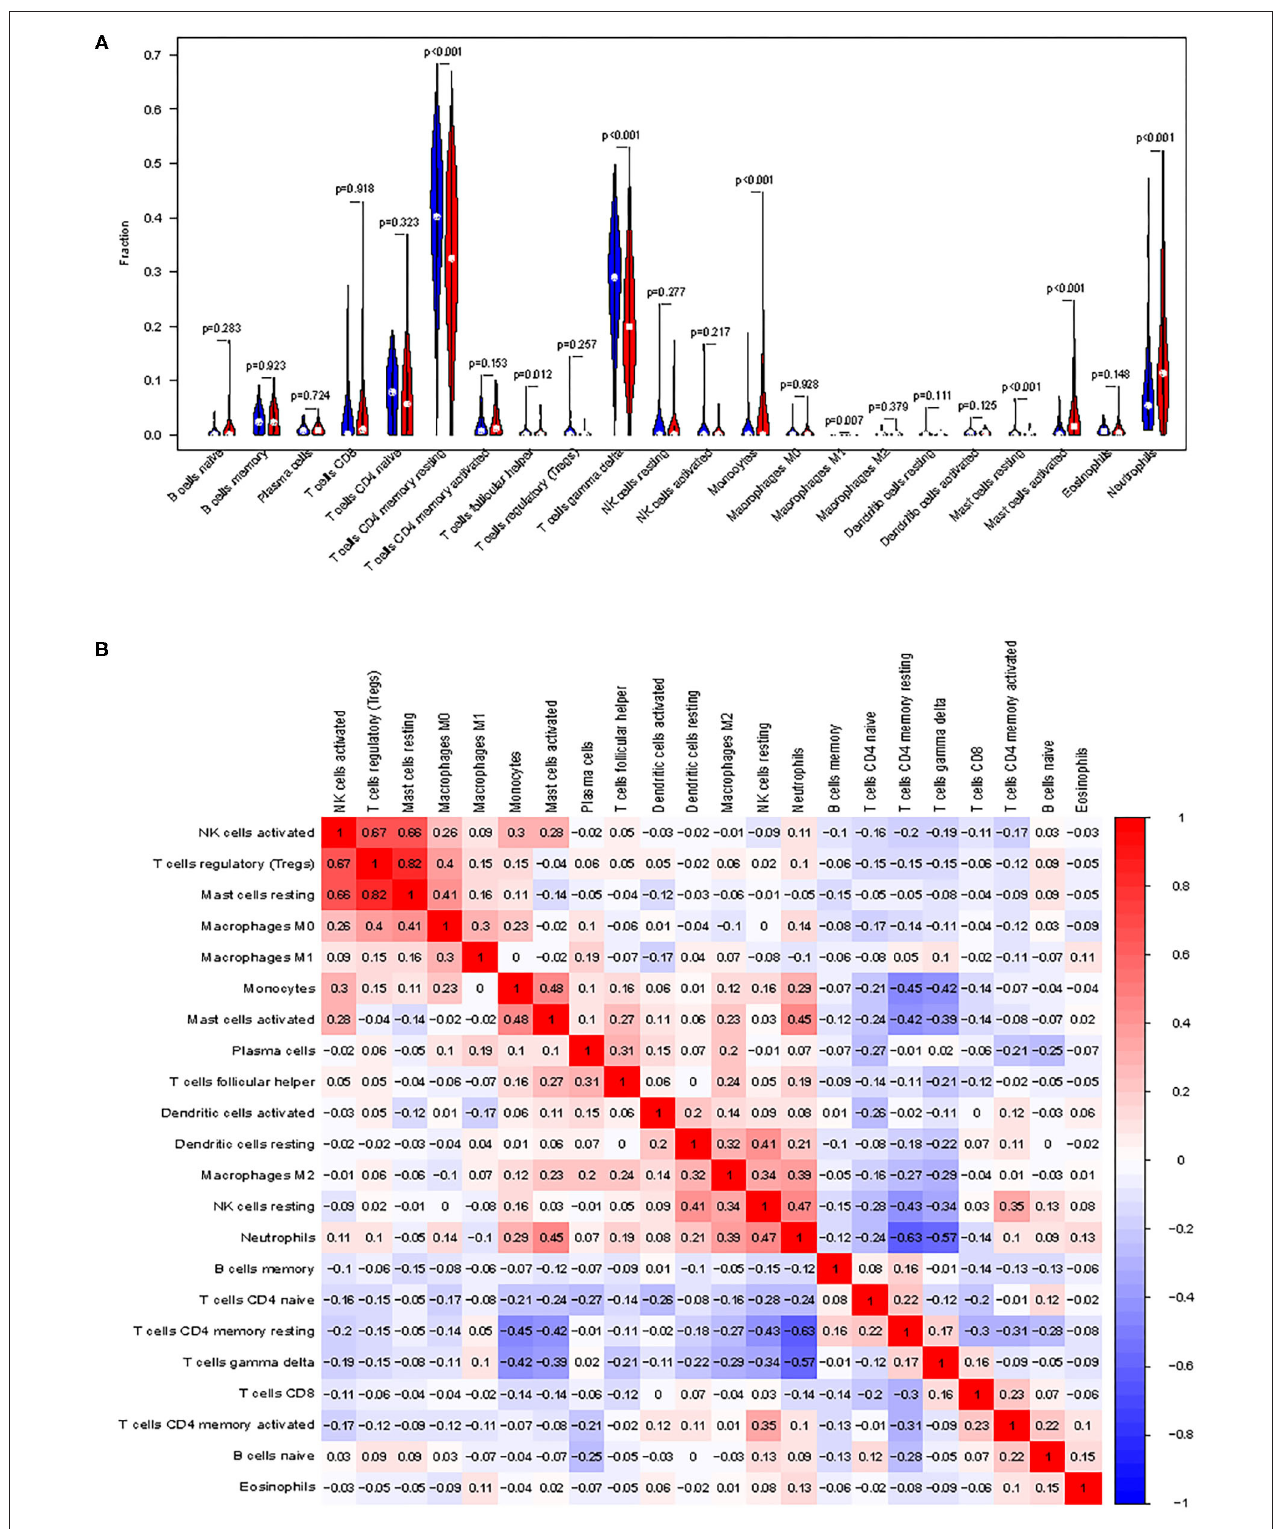
FIGURE 6 | Distribution and visualization of immune cell infiltration. (A) Comparison of 22 immune cell subtypes between acute myocardial infarction tissues and normal tissues. Blue and red colors represent normal and acute myocardial infarction samples, respectively. (B) Correlation matrix of all 22 immune cell subtype compositions. Both horizontal and vertical axes demonstrate immune cell subtypes. Immune cell subtype compositions (higher, lower, and same correlation levels are displayed in red, blue, and white, respectively).